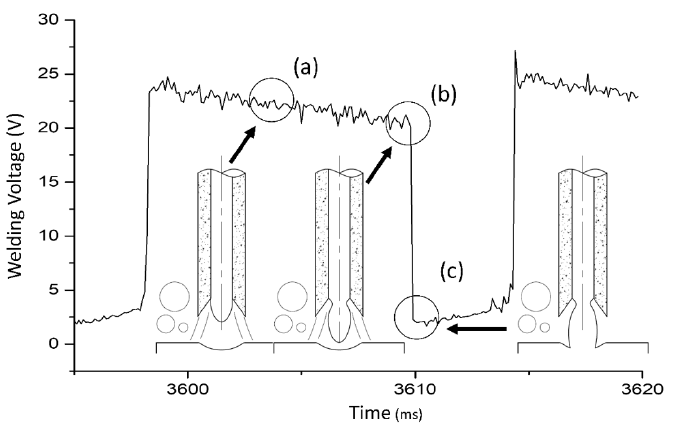
Figure 2. Methodology to determine Ua + c (adapted from the work in [5]): (a) welding voltage while the arc is operating, (b) instant immediately before the short circuit, and (c) moment immediately after the short circuit. At point (b), the arc length is close to zero, the voltage drop in the arc column can be neglected, and the difference between the voltages at the indicated points provides an estimate of Ua + c [35].